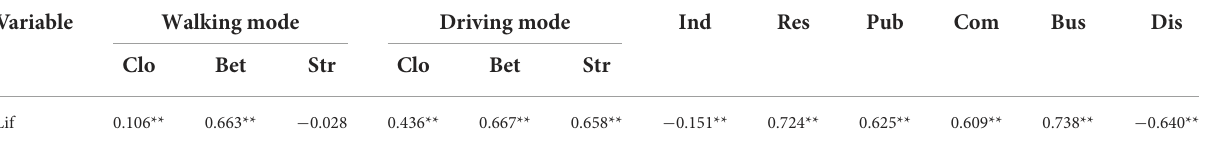
TABLE 2 Spearman’s correlation coefficient and significance test.